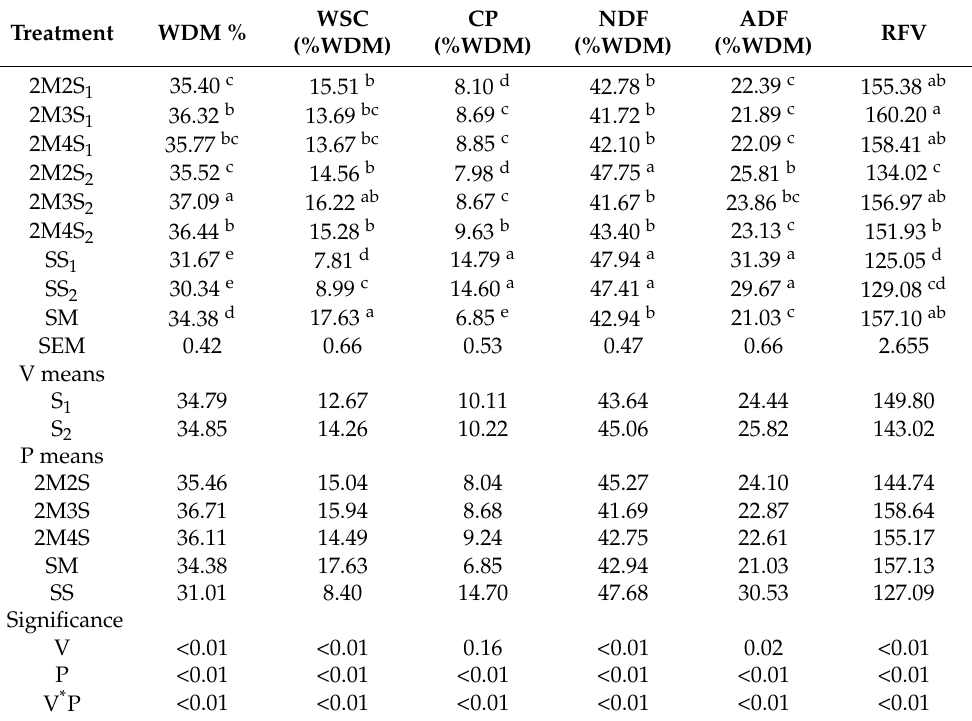
Table 4. Chemical composition of maize and soybean before ensiling as affected by different planting patterns in